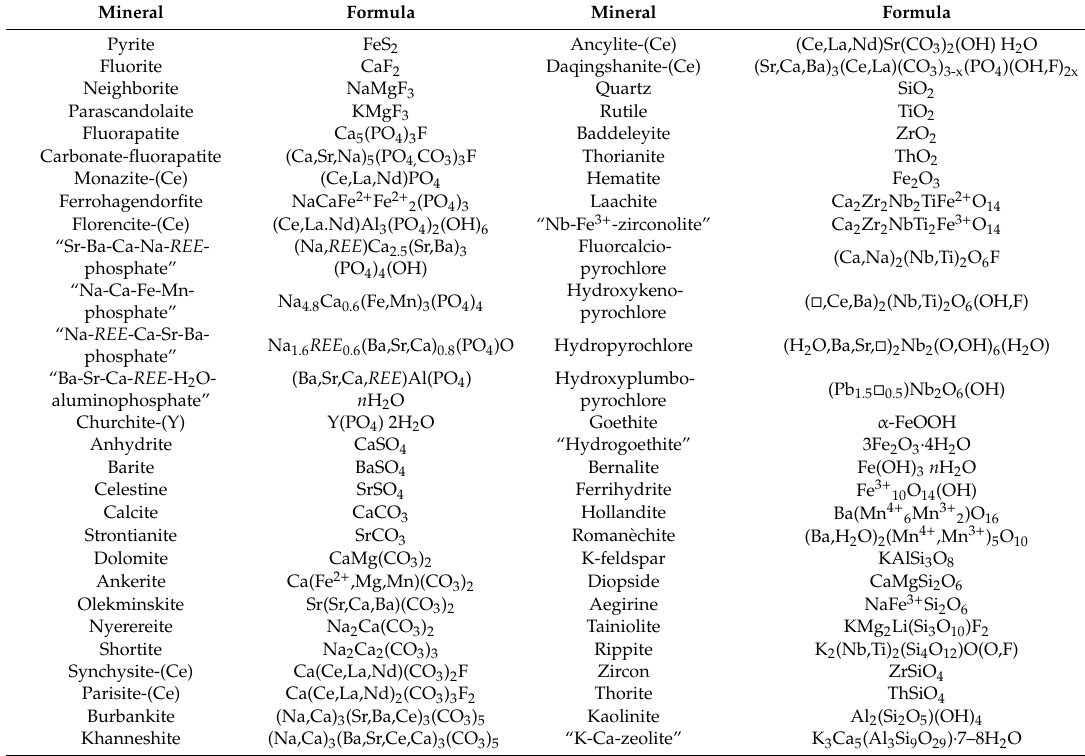
Table 1. List of minerals found in the Chuktukon calciocarbonatites.